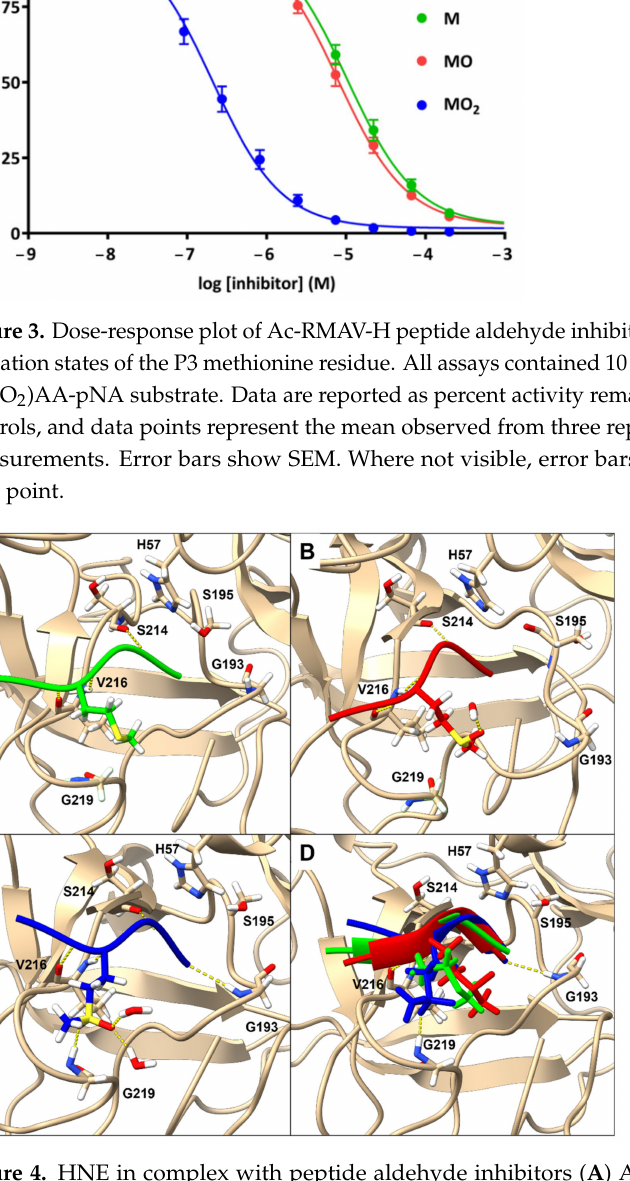
Figure 4. HNE in complex with peptide aldehyde inhibitors ( A ) Ac-RMAV-H, ( B ) Ac-RM(O)AV- H, ( C ) Ac-RM(O 2 )AV-H, and ( D ) overlayed. Each complex used the final snapshot from a 10 ns simulation and was energy minimised prior to alignment of the backbone atoms. Each peptide is represented by a ribbon backbone structure and key P3 methionine sidechain that illustrates their modified binding pattern to HNE. Measurement of the distance between carbonyl atoms for the three variants revealed a 1.52 Å disparity between methionine sulfone versus native methionine, and only a 0.18 Å displacement between methionine sulfoxide and native methionine. This shift in conjunction with the hydrogen bond seen between Gly218/219 would suggest that the movement of the peptide backbone is caused by the hydrogen bond network of this